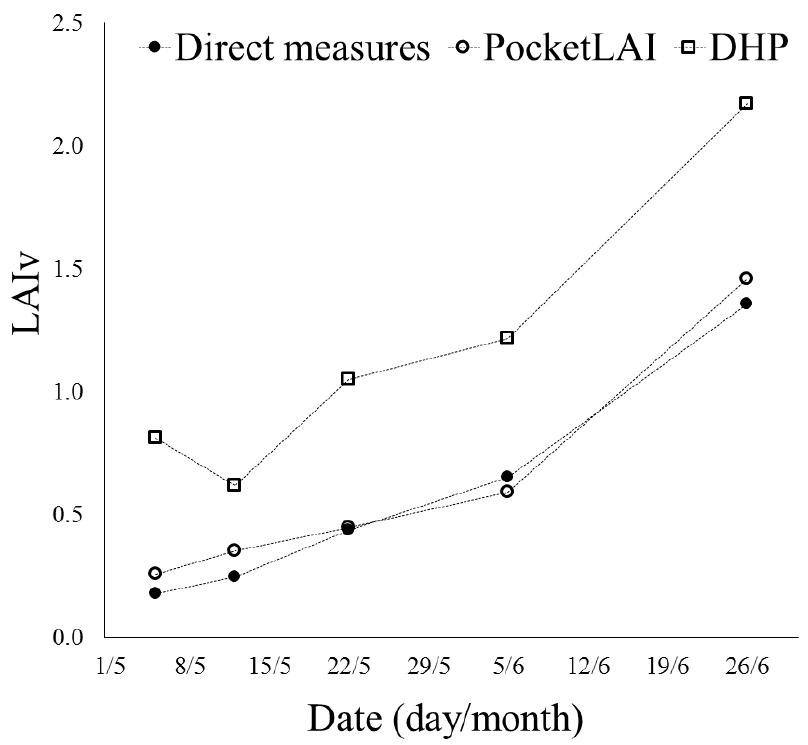
Figure 3. Average trend of LAIv observed during the monitoring of three rows from the beginning of May to the end of June, with direct and indirect methods.